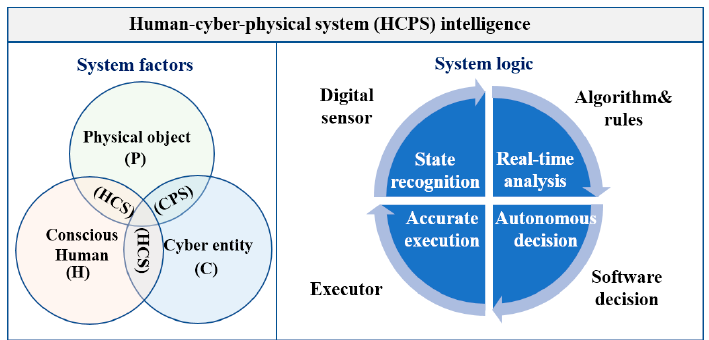
Figure 9. HCPS intelligence (Type III).